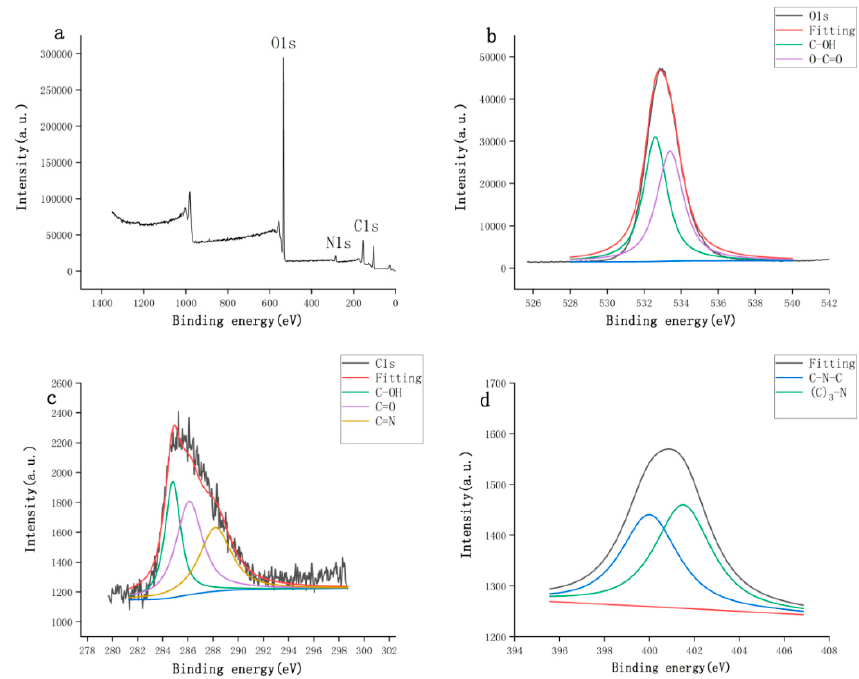
Molecules 2019 , 24 , x FOR PEER REVIEW Figure 4. The surface composition and elemental analysis of the prepared STC-NPs by XPS. ( a ) X-ray Figure 4. The surface composition and elemental analysis of the prepared STC ‐ NPs by XPS. ( a ) X ‐ ray photoelectron spectroscopy survey of STC-NPs. ( b ) C1s. ( c ) O1s and ( d ) N1s. photoelectron spectroscopy survey of STC ‐ NPs. ( b ) C1s. ( c ) O1s and ( d ) N1s.